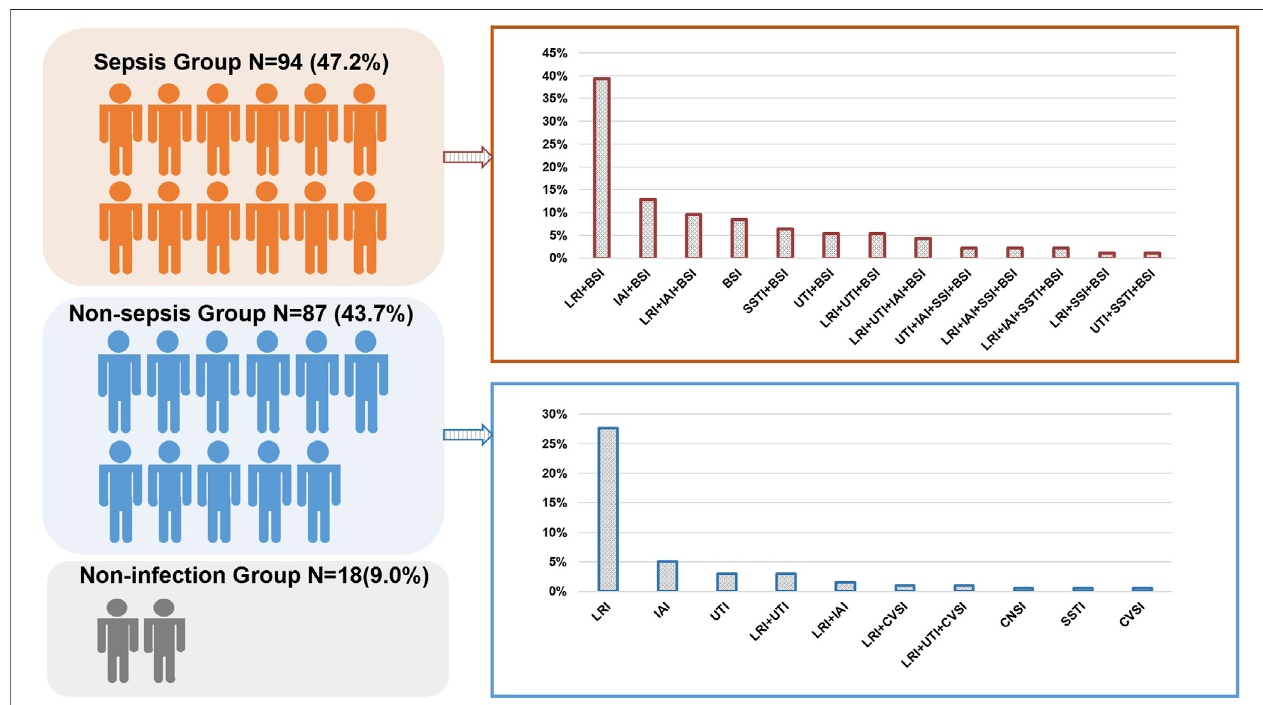
FIGURE2| Distributionofthesepsisandnon-sepsisgroupinthestudy.BSI,bloodstreaminfection;CVSI,cardiovascularinfection;LRI,lowerrespiratoryinfection; SSTI, skin or soft-tissue infection; UTI, urinary tract infection; IAI, intra-abdominal infection; CNSI, central nervous system